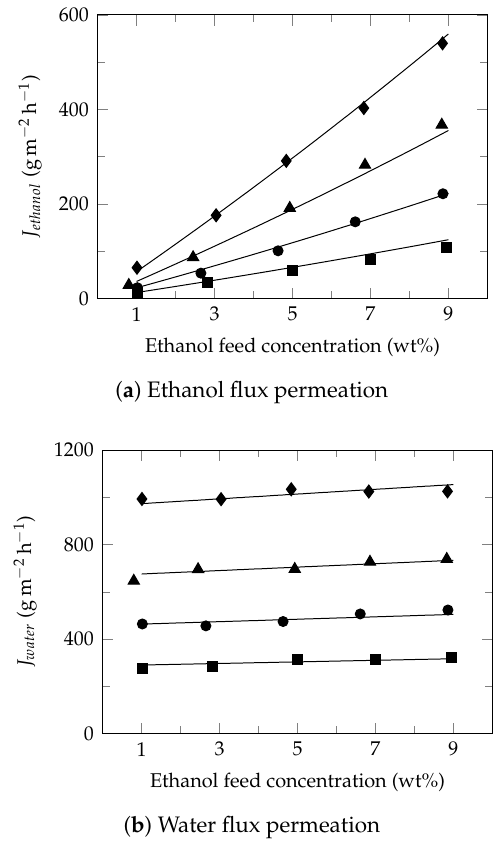
Figure 7. Ethanol and water fluxes experimental (symbol) and simulation (line). Feed temperature: 34°C ( (cid:4) ), 40°C ( ), 45°C ( (cid:78) ) and 50°C ( (cid:7) ). (cid:32)